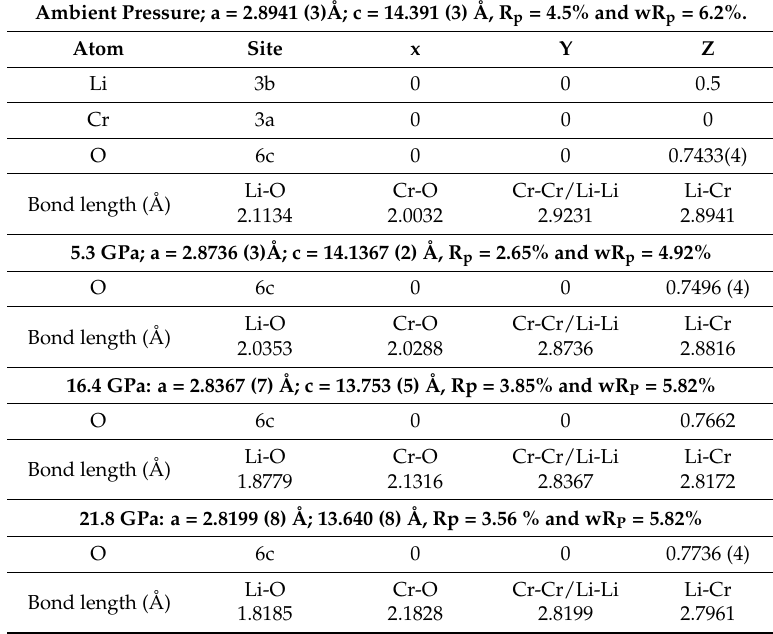
Table 1. Refined structural parameters for LiCrO 2 at ambient and high pressures.